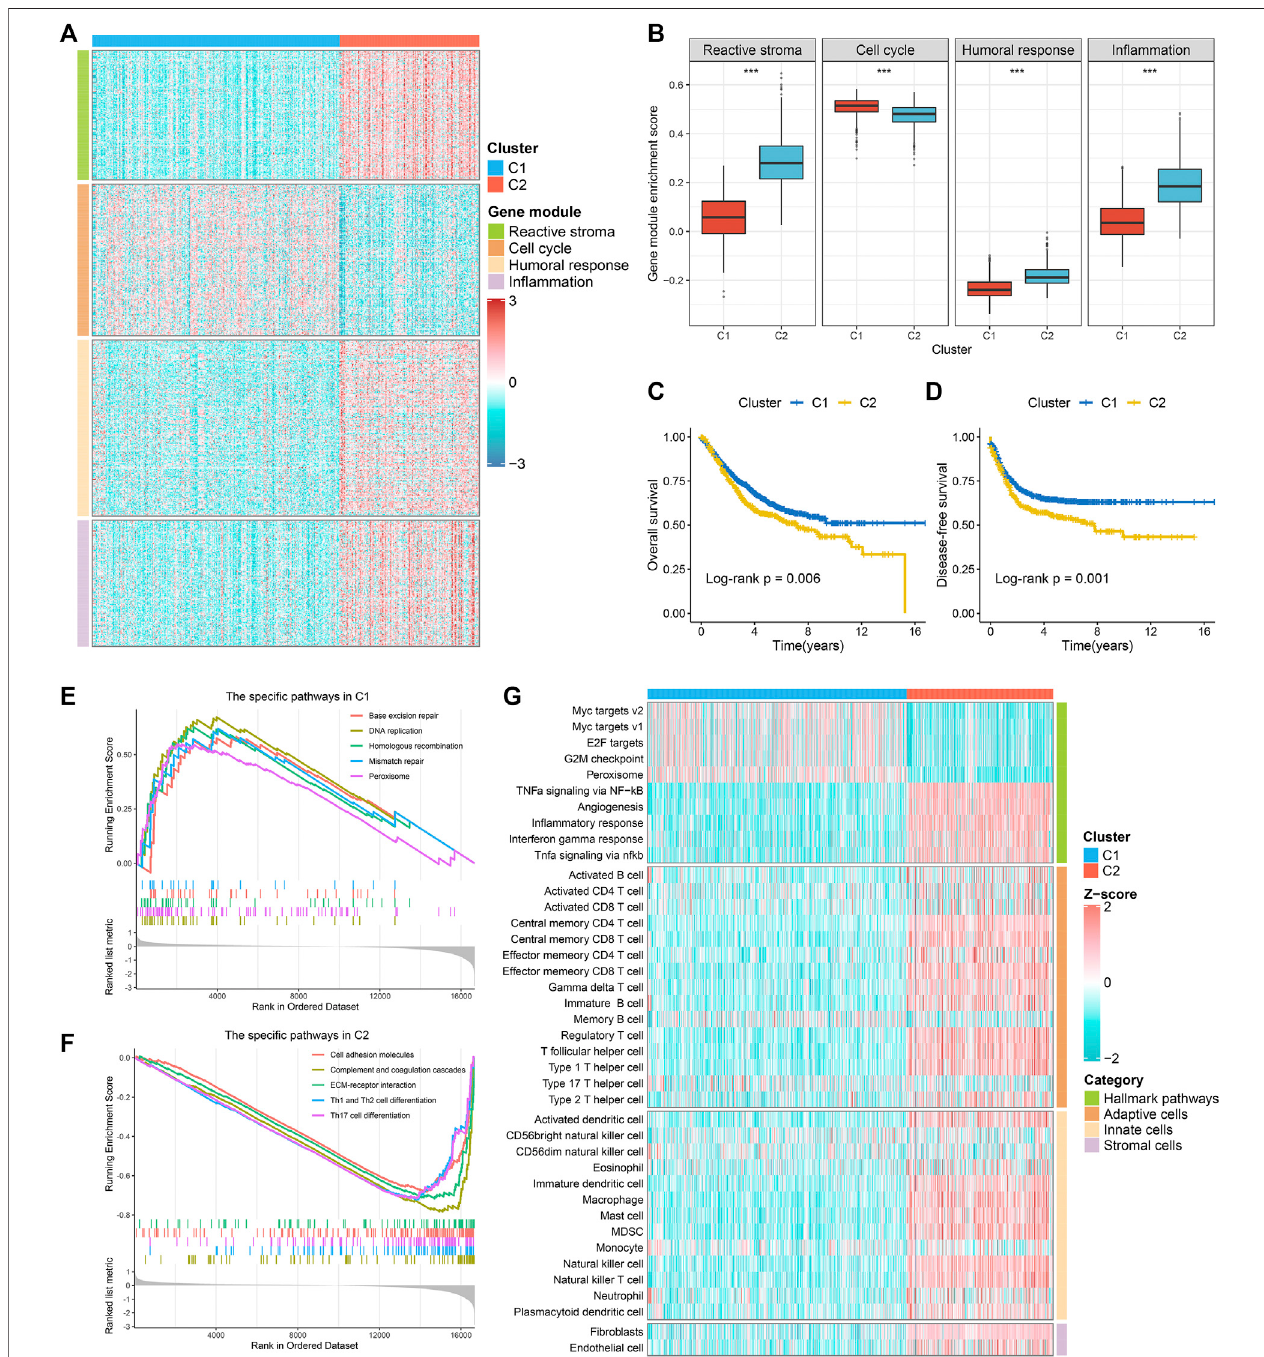
FIGURE 1 | The speci fi c functions and survival status of each subtype in the meta -GEO cohort. (A) The expression pro fi les of gene modules between two subtypes. (B) The ssGSEA algorithm was performed to quantify the relative abundance of four gene modules between two subtypes. (C,D) Kaplan-Meier survival analysisofoverallsurvival (C) anddisease-freesurvival (D) accordingtothetwosubtypes. (E,F) .GSEAwasperformedtoidentifyspeci fi cKEGGpathwaysinC1 (E) and C2 (F) . (G) . The hallmark analysis (GSVA) and immune cell in fi ltration estimation (ssGSEA) of two subtypes.